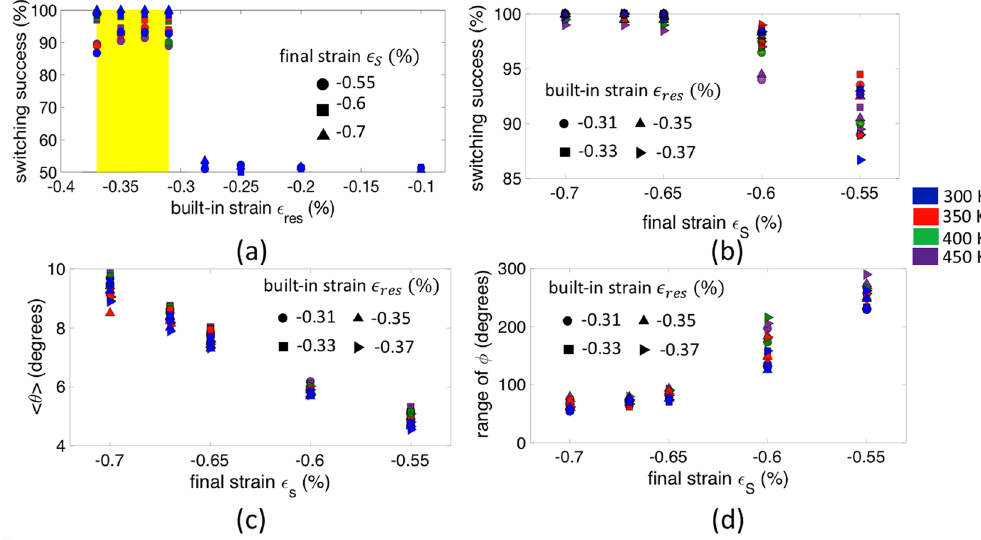
Figure 3. ( a ) Plot illustrating the dependence of the switching success on the built-in strain, ( b ) Impact of the final strain ∈ s on the switching success which stems from the effect on the detected mean amplitude ( θ ) and range of the phase ( φ ) of the spin wave as shown in ( c ) and ( d ), respectively. Symbols illustrate different final strains ∈ s in ( a ) and built-in strains in ( b – d ) while colors indicate different temperatures (300 K–450